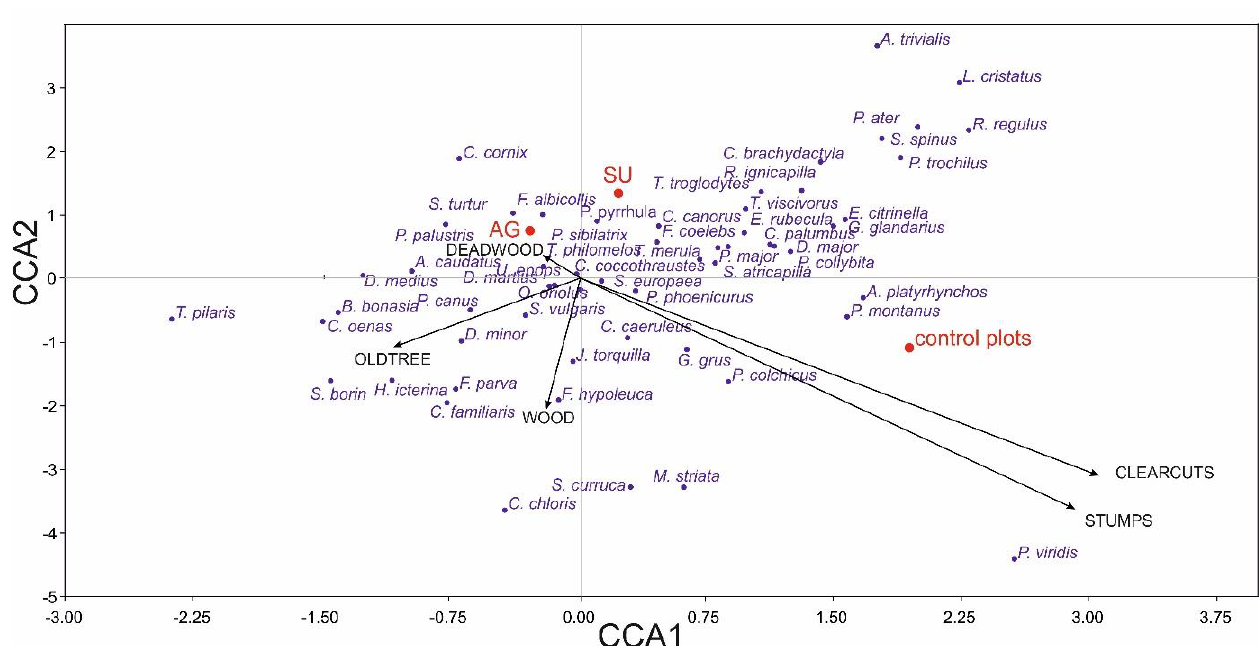
Figure 3. Correspondence Canonical Analysis plots showing the ordination of bird species wintering (above) or breeding (below) in examined plots along the first two axes and their correlation with occurrence of goshawks (AG), Ural owls (SU) and control plots, as well as selected environmental variables (W OOD — deciduous vs. coniferous, O LD T REES — number of veteran trees, D EAD W OOD — number of large snags and logs, C LEAR C UTS — area of clear − cuts and S TUMPS — number of fresh stumps). The arrows represent the environmental variables selected, and the dots represent the bird species. The direction of the arrows indicates their correlation with an axis or a particular species. The length of the arrow represents the size of the effect, the longer the arrow the stronger the relationship of that variable with the community.